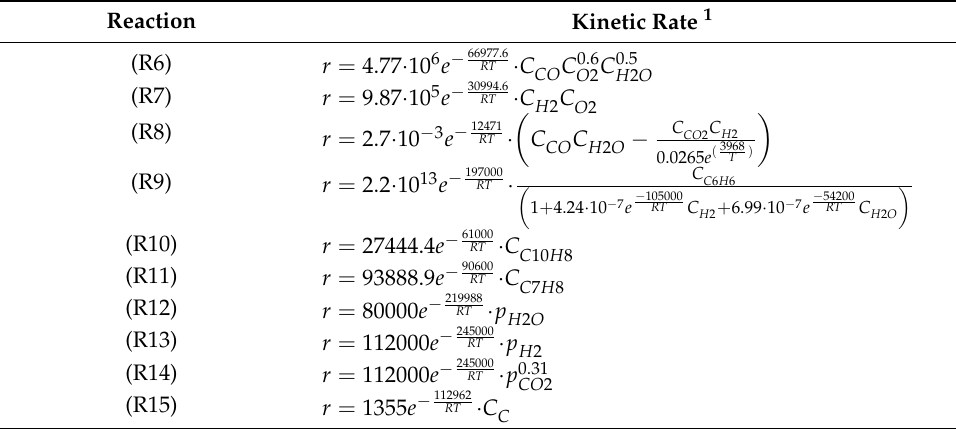
Table 2. Gasification reaction rates.